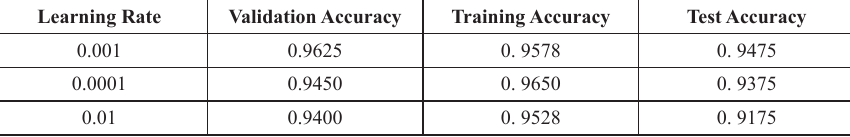
Table 7. Accuracy of different learning rates on validation, train, and test set